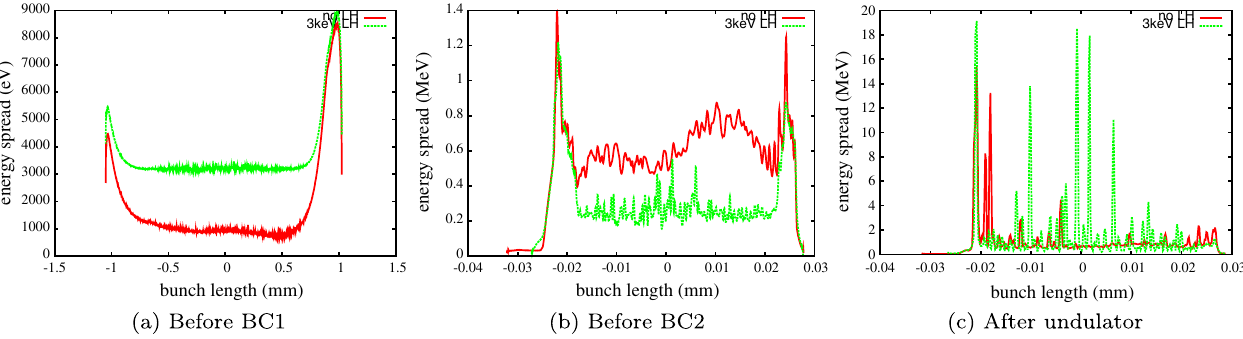
FIG. 14. Evolution of the slice energy spread along the machine at (a) before BC1, (b) before BC2 and (c) after undulator. The red curves are with laser heater off, and the green curves are laser heater at 3 keV. Beam current is 1 kA.